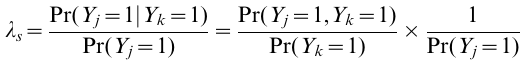
Table S2 MAF dependent prior. Table of the standard deviation of the prior distribution of the log relative risk (RR) as a function of risk allele frequency (RAF).